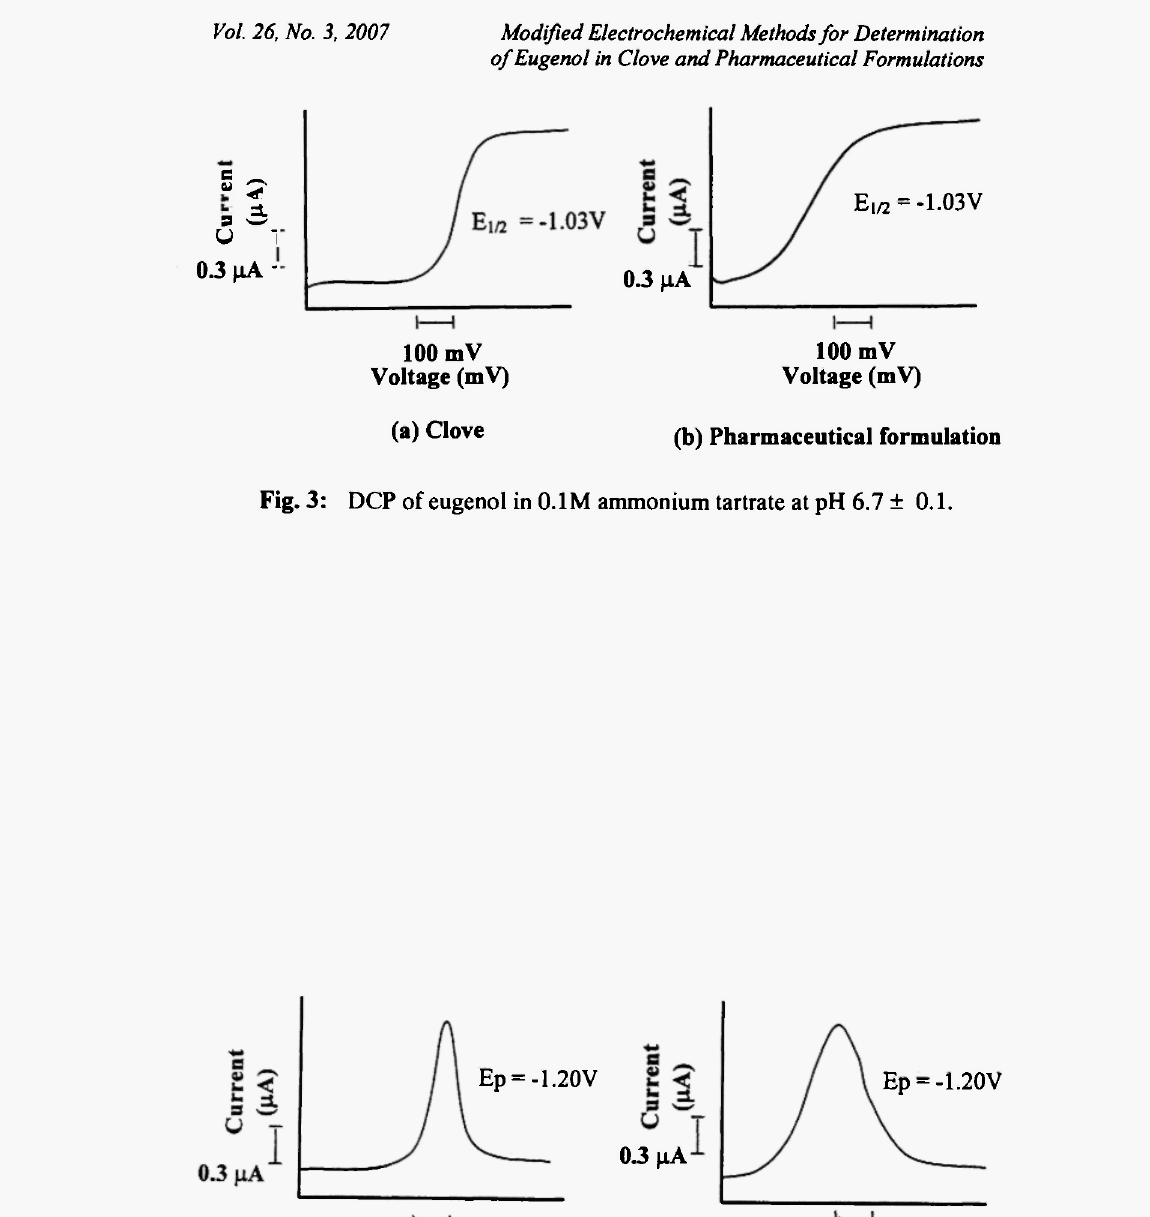
Fig. 4: DPP of eugenol in 0.1M ammonium tartrate at pH 6.7 ± 0.1.